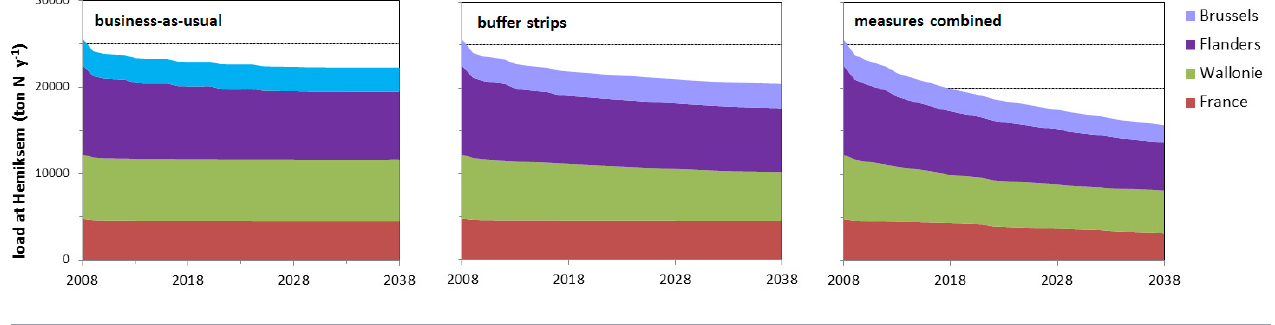
current practice of manure processing or cattle stock